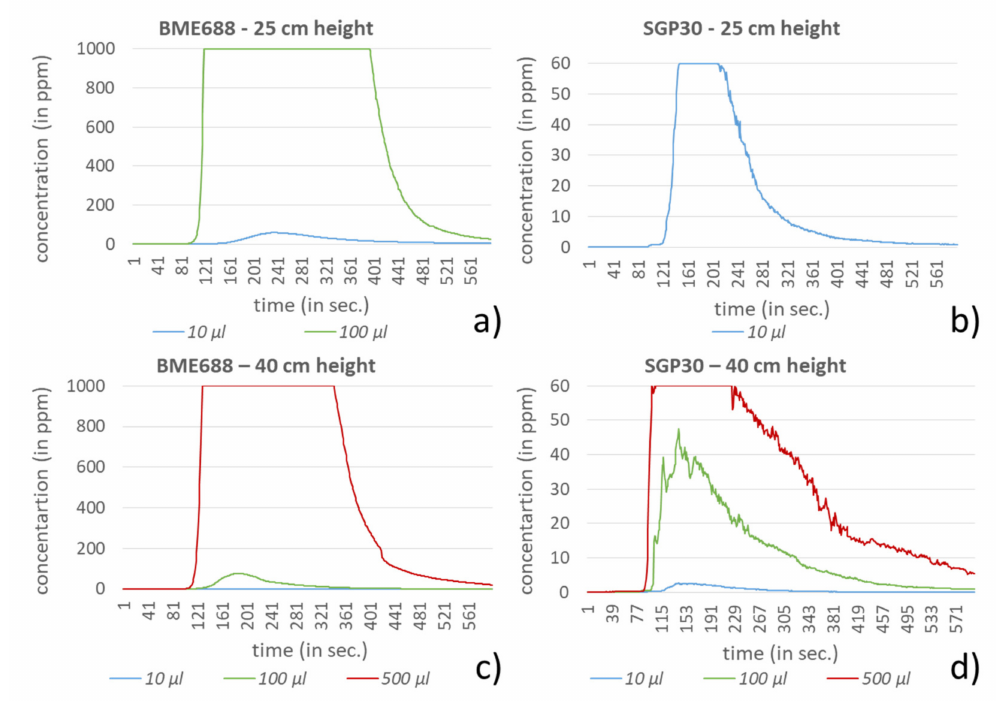
Figure 10. Response of BME688 and SGP30 for different amounts of formic acid and for 25 and 40 cm height above the emission source. In ( a ) a measurement height of 25 cm for BME688 and ( b ) for SGP30 is used. In ( c ) the measurement height was changed to 40 cm for BME688 and ( d ) for SGP30.